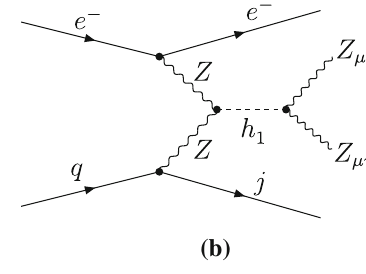
Fig. 4 The leading order